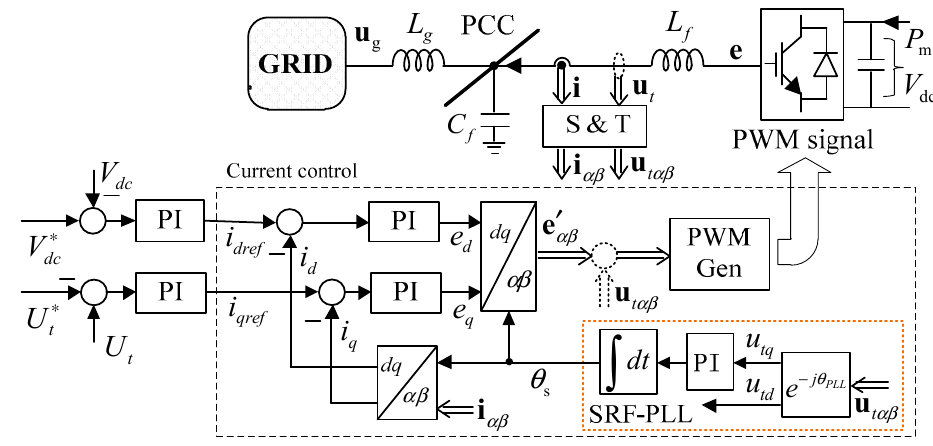
Figure 1. Simplified diagram of a voltage source converter (VSC) current control with phase-locked loop (PLL).